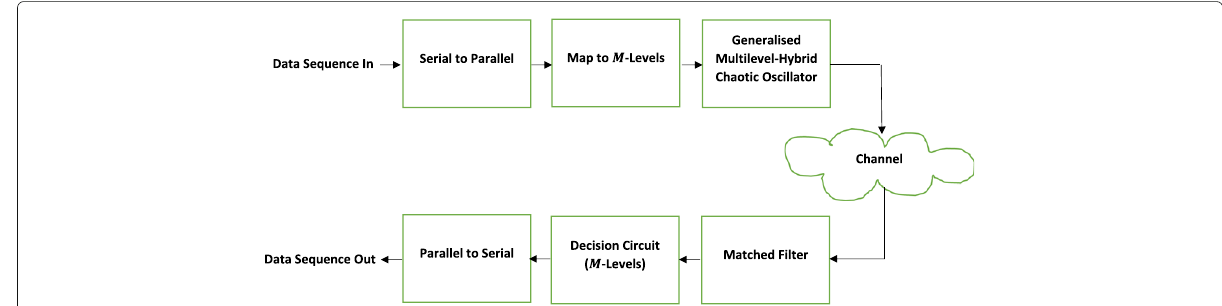
Fig. 4 Block diagram of the proposed hybrid chaotic wireless communication system based on GM-HCO